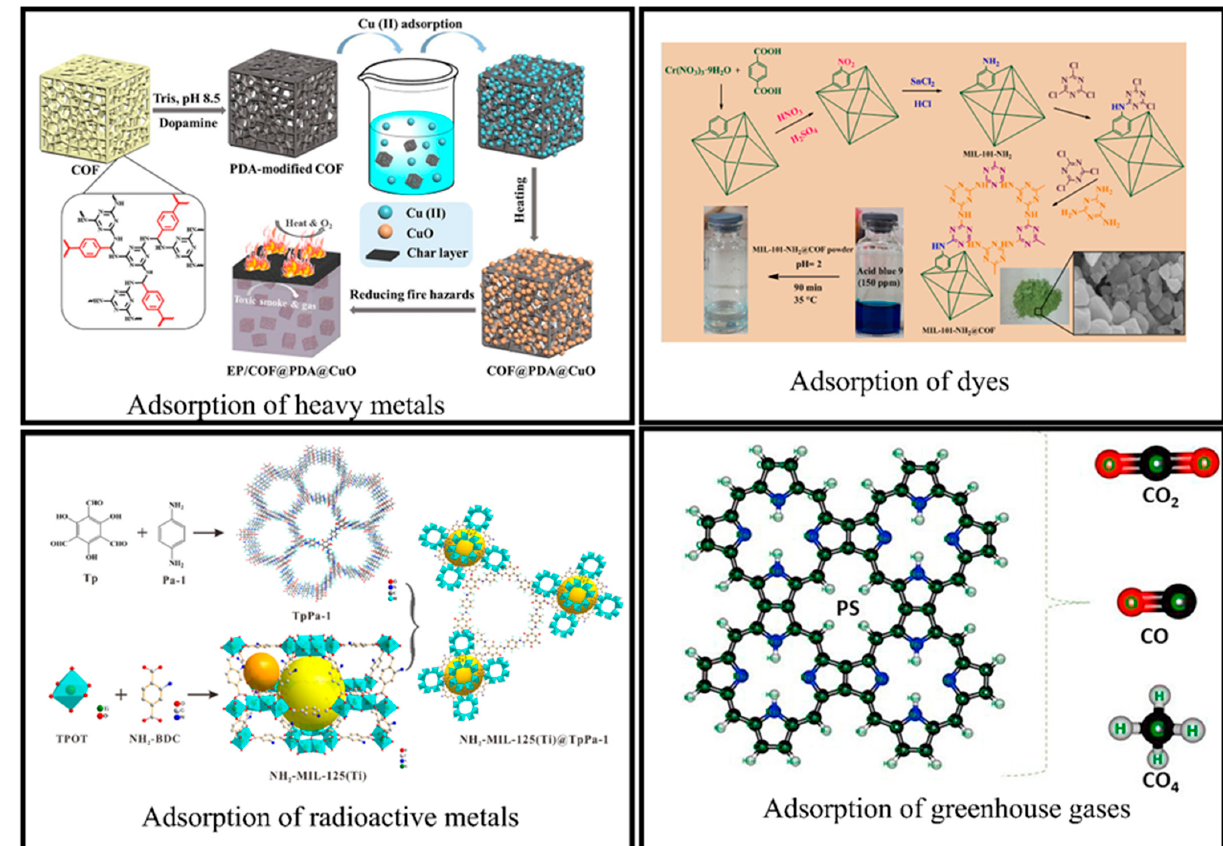
Figure 4. Adsorption of metals, toxic chemicals, and greenhouse gases. Adapted with permission from references [109], copyright 2021 Elsevier, [113] copyright 2021 American Chemical Society, [116] copyright 2021 Elsevier, and [117] copyright 2021 Elsevier.